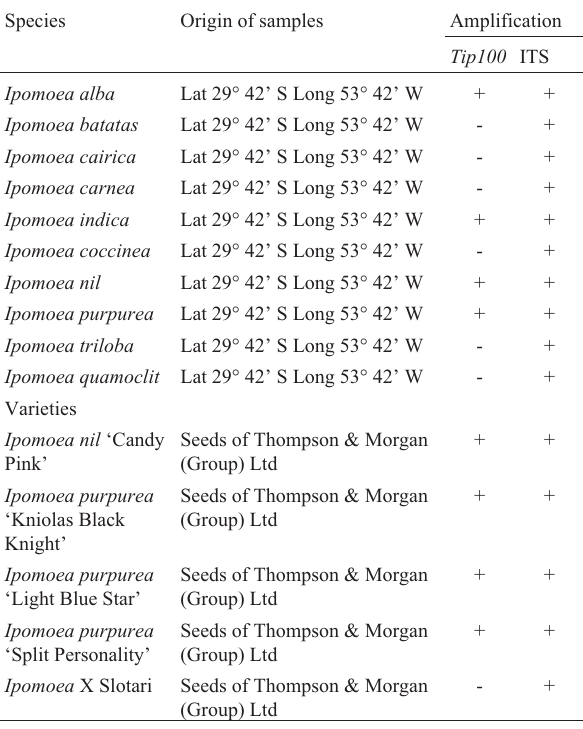
Table 1 - Ipomoea species and localities, as well as PCR results for the transposon Tip100 and Internal Transcribed Spacers